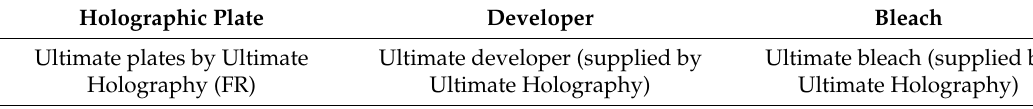
Table 1. Typical developer and bleach solutions